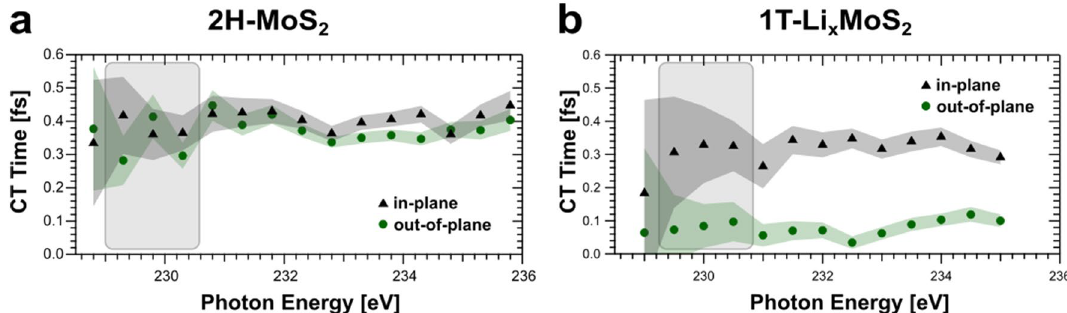
Figure 3. In-plane τ (cid:31) (black triangles) and out-of-plane τ ⊥ (green circles) charge transfer times of S3p excited states in 2H-MoS 2 ( a ) and 1T-Li x MoS 2 ( b ) from CHC analysis of Auger- (d) and Raman-channels (l) and the natural S2s core hole lifetime. Resonant excitation into the conduction band minimum occurs for incident photon energies 229.5 eV to 230.5 eV just above the S2s → S3p X-ray absorption resonance maximum. Error bars (shaded) for each photon energy, orientation and sample result from error propagation through the CHC analysis from the fitted intensities (Fig. 2) of each underlying autoionization